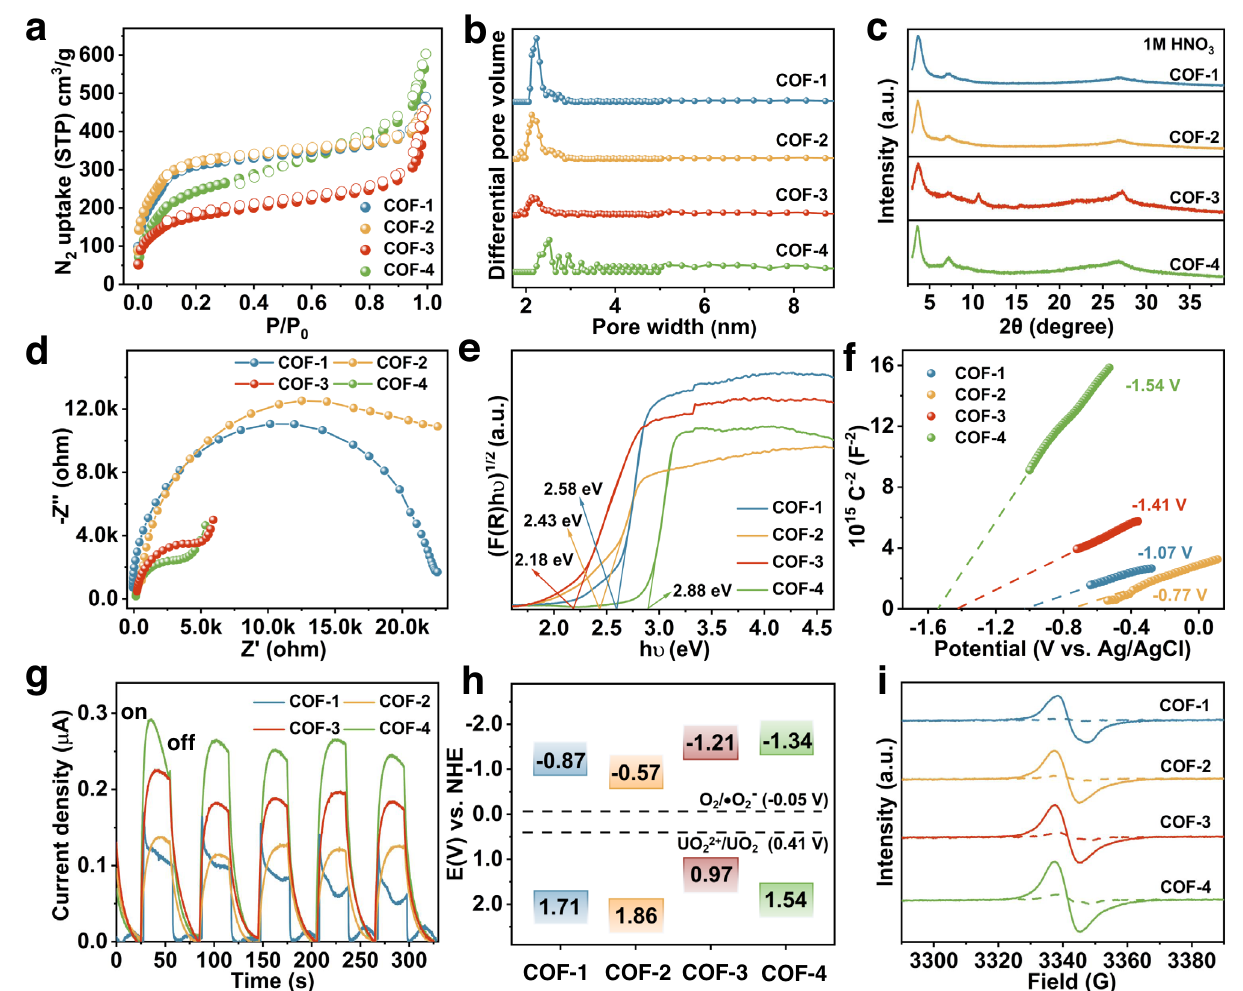
Fig. 3 | Porosity, stability and optoelectronic properties of COFs. a N 2 sorption isotherms measured at 77K for COF-1, COF-2, COF-3, and COF-4. b Pore size dis- tribution calculated using a DFT method from N 2 isotherms measured at 77K for COF-1,COF-2,COF-3,andCOF-4. c PXRDpatternsofCOF-1,COF-2,COF-3,andCOF- 4 after treatments in 1M HNO 3 over 24h. d Electrochemical impedance spectra (EIS) of COF-1, COF-2, COF-3, and COF-4. e Kubelka-Munk plots of COF-1, COF-2,